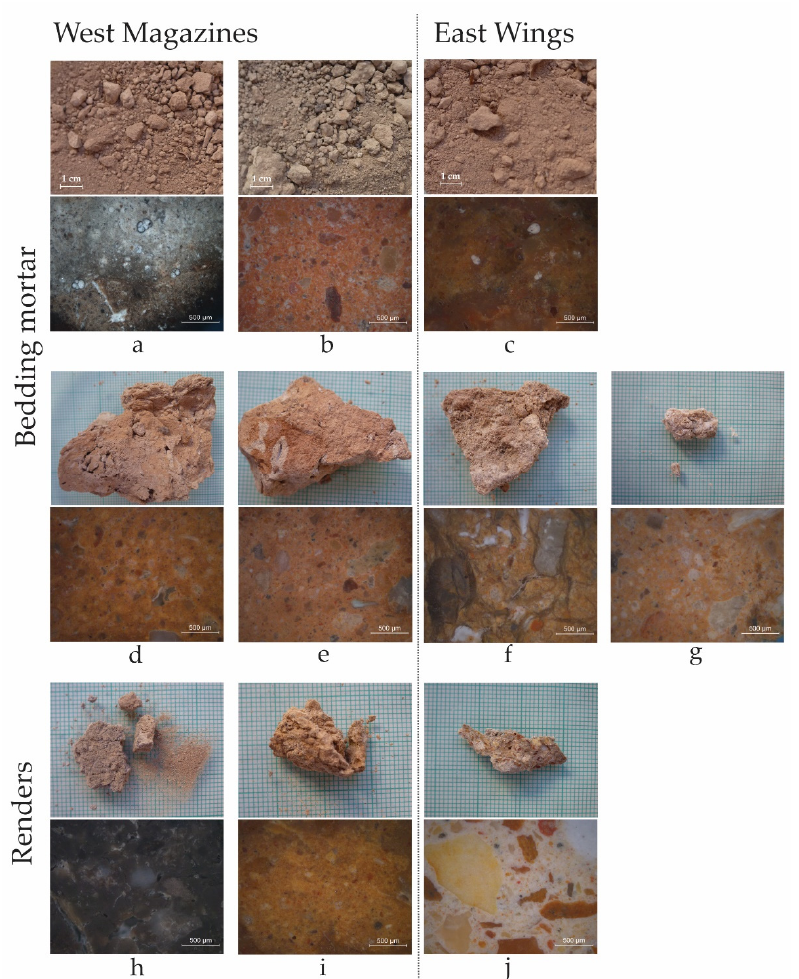
Figure 4. Set of samples from the Palace of Knossos, both as-received and in polished section observation. Bedding mortar samples from West Magazines ( a ) KN-BM1A; ( b ) KN-BM2A; ( d ) KN- CM1A; ( e ) KN-CM2A. Bedding mortar from East Wing ( c ) KN-BM3A; ( f ) KN-CM3A; ( g ) KN-CM4A. Render samples from West Magazines ( h ) KN-Pl1A; ( i ) KN-Pl2A; render sample from East Wing ( j ) KN-Pl3A.